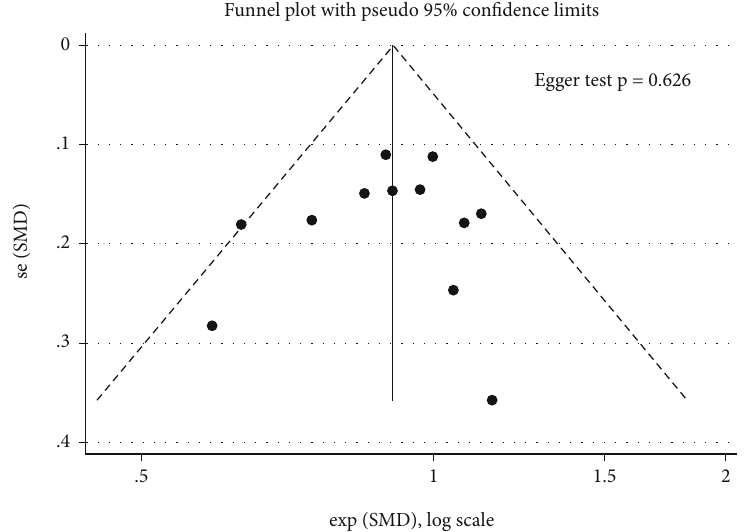
Figure 6: Funnel plot for LOS with nonsigni fi cant Egger ’ s test suggesting no publication bias. Eggers test = 0 : 32